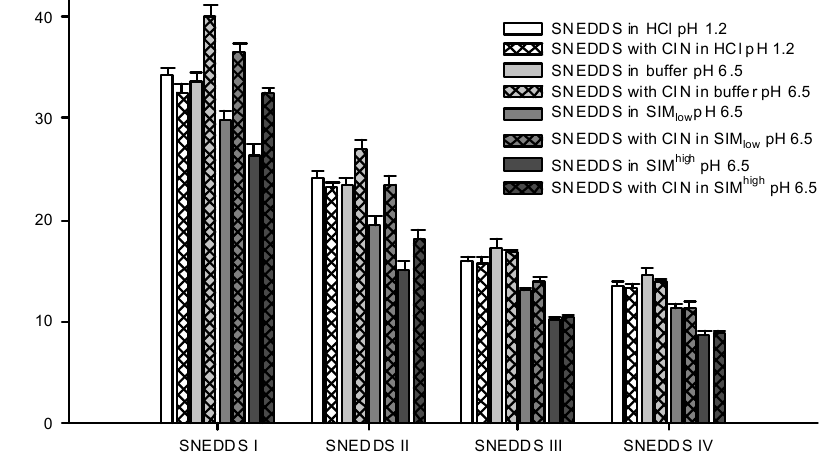
Figure 5. Particle sizes of formed nanoemulsions in various media determined by DLS. SNEDDSs with cinnarizine (25 mg/g SNEDDS) and without cinnarizine were dispersed in the media, 1% ( w / w ) at 37 °C. The bars represent mean ± SD ( n = 3), between two and four measurements obtained on each sample.